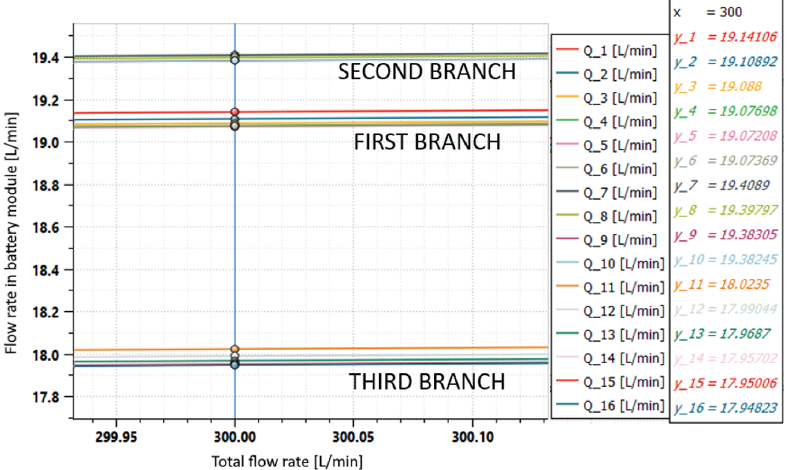
Figure 12. Flow rates in the individual battery modules for an inlet flow of 300